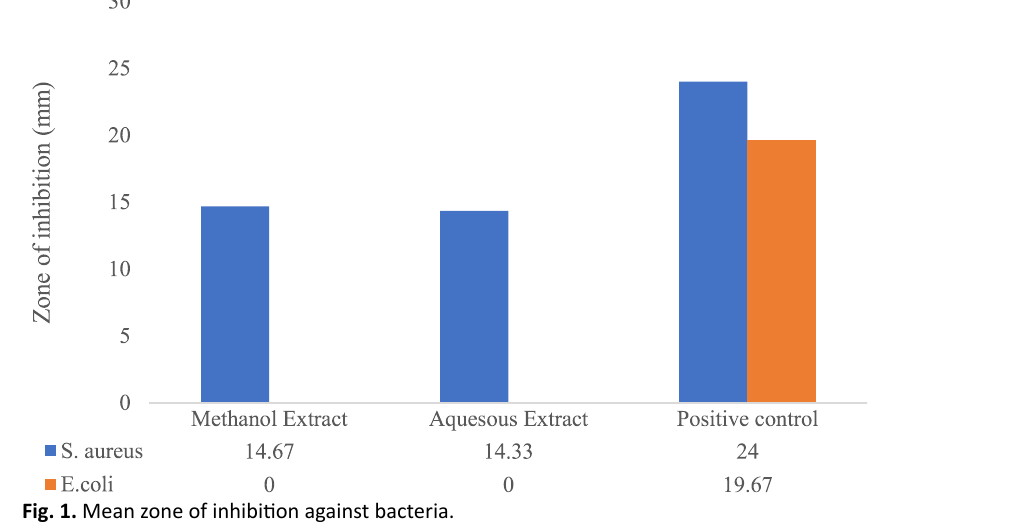
Fig. 1. Mean zone of inhibition against